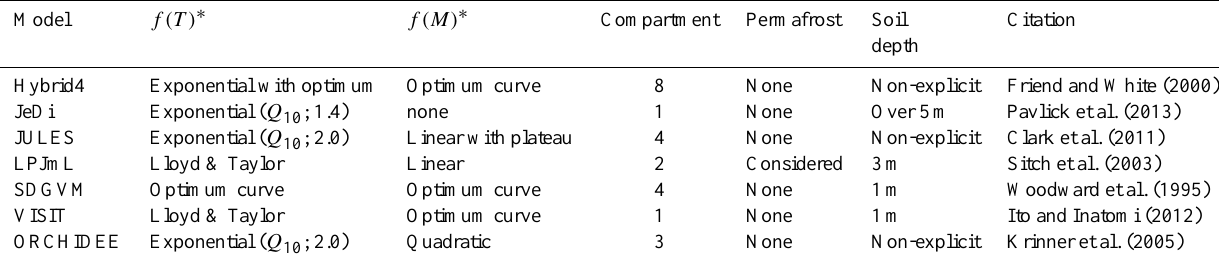
Table 1. Description of SOC-relevant processes in each biome model. Model